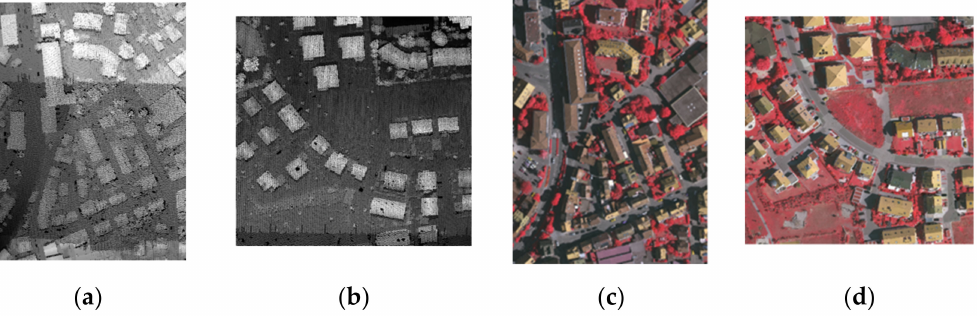
Figure 15. New data from ISPRS Vaihingen datasets: ( a ) new LiDAR data 1; ( b ) new LiDAR data 2; ( c ) aerial IR image 1; ( d ) aerial IR image